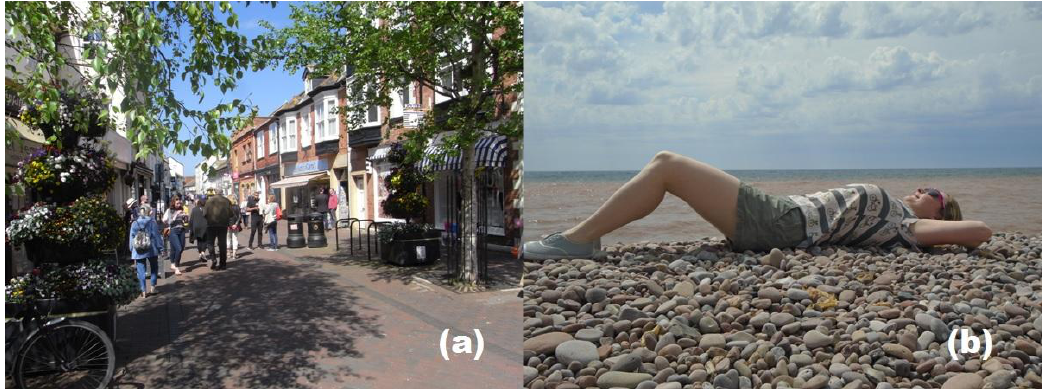
Figure 3. ( a ) Adventitious sun exposure and ( b ) elective sun exposure.